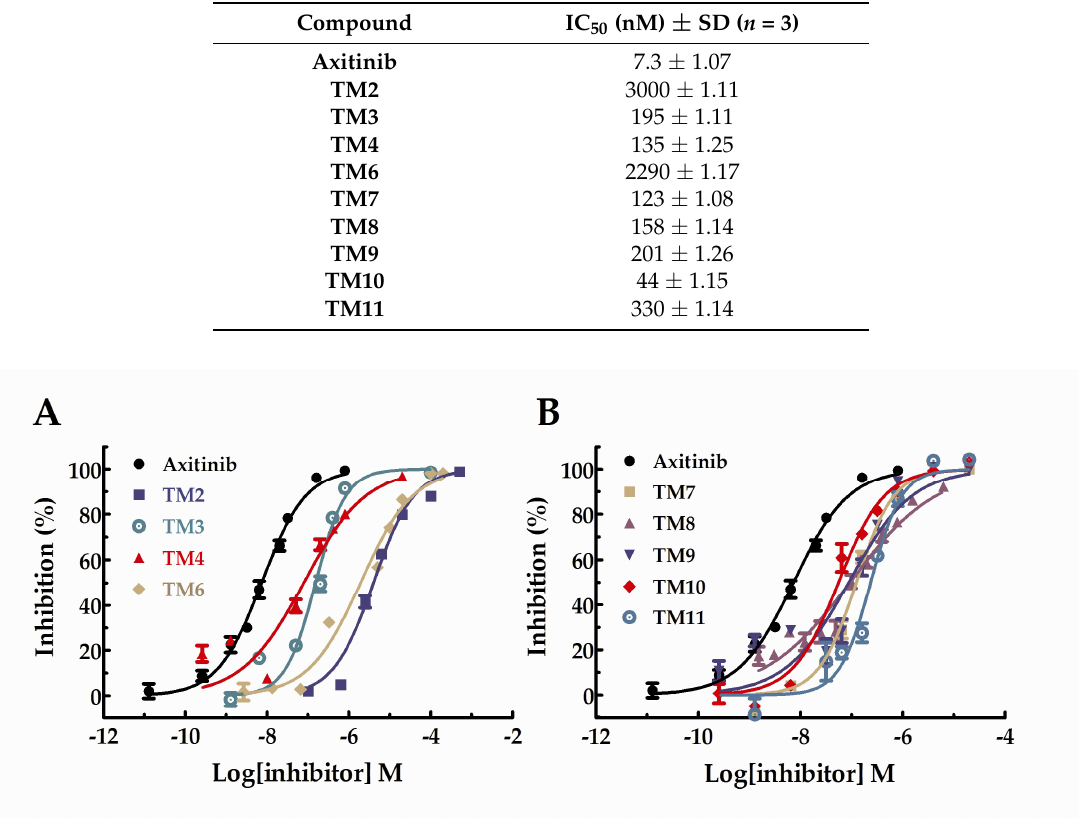
Figure 2. Dose–response curves for the inhibition of VEGFR-2 in the presence of axitinib derivatives.